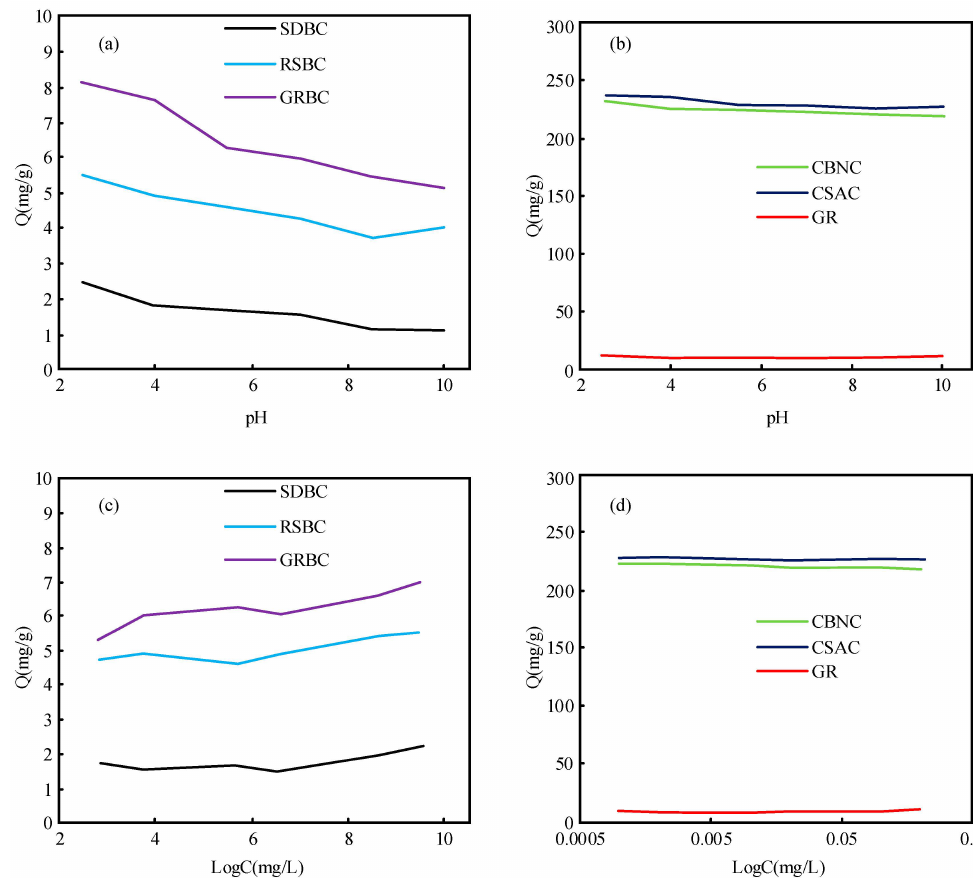
Figure 2. Effect of pH and ionic strength on DEP adsorption by absorbents.( a ) Effect of pH on the adsorption of SDBC, RSBC and GRBC; ( b ) Effect of pH on the adsorption of CBNC, CSAC and